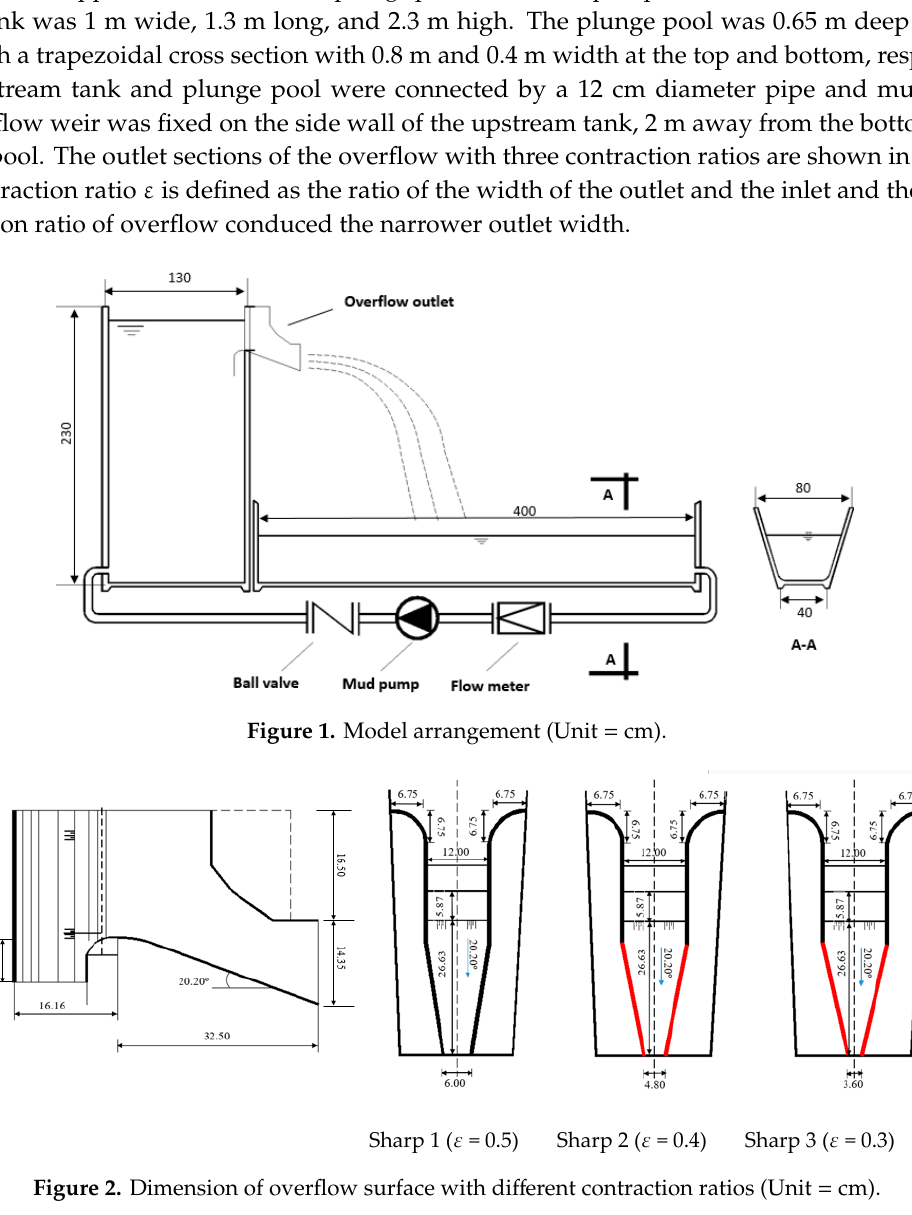
Figure 2. Dimension of overflow surface with different contraction ratios (Unit = cm).